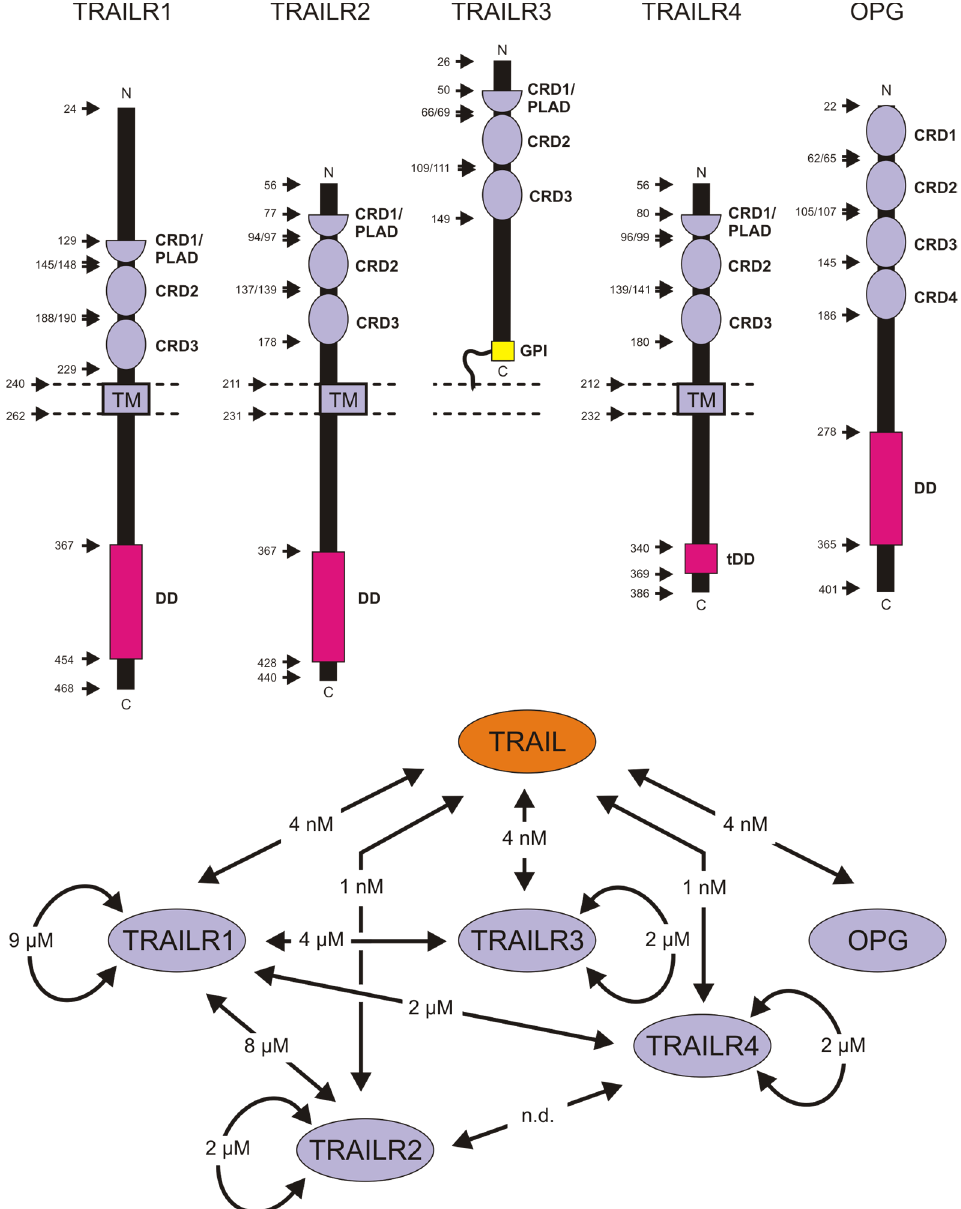
Figure 2. Domain architecture of the TRAIL receptors and their interactions. CRD, cysteine-rich domain; DD, death domain; GPI, glycosylphosphatidylinositol; PLAD, pre-ligand binding assembly domain; TM, transmembrane domain. In contrast to the CRDs, the PLAD is functionally and not structurally defined and matches with CRD1. Please note OPG is a soluble protein; its DD is not involved in the activation of intracellular signaling cascades. Affinities of ligand-independent receptor receptor interactions and for TRAIL binding are indicated [41,42].